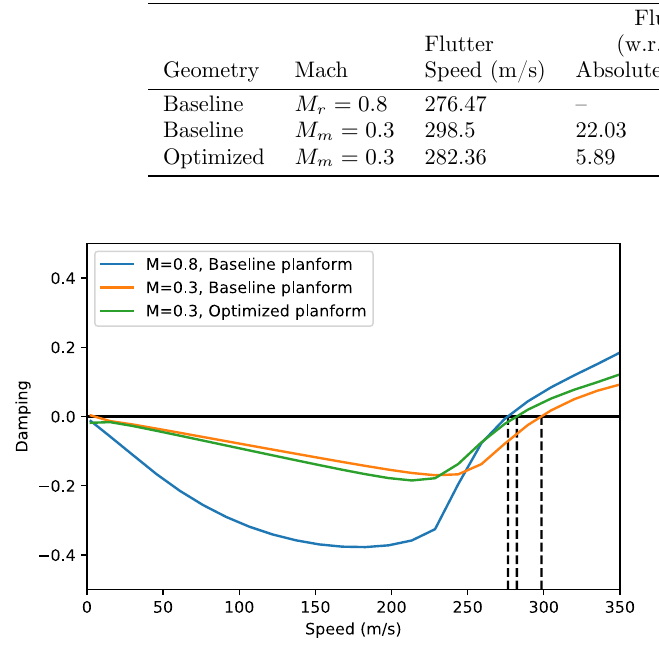
Fig. 5. The geometry of the optimized wingbox is updated according to the wing planform (a) while keeping the same layout as the reference wing (b). Table 3. Flutter speed error of the baseline and optimized configurations.